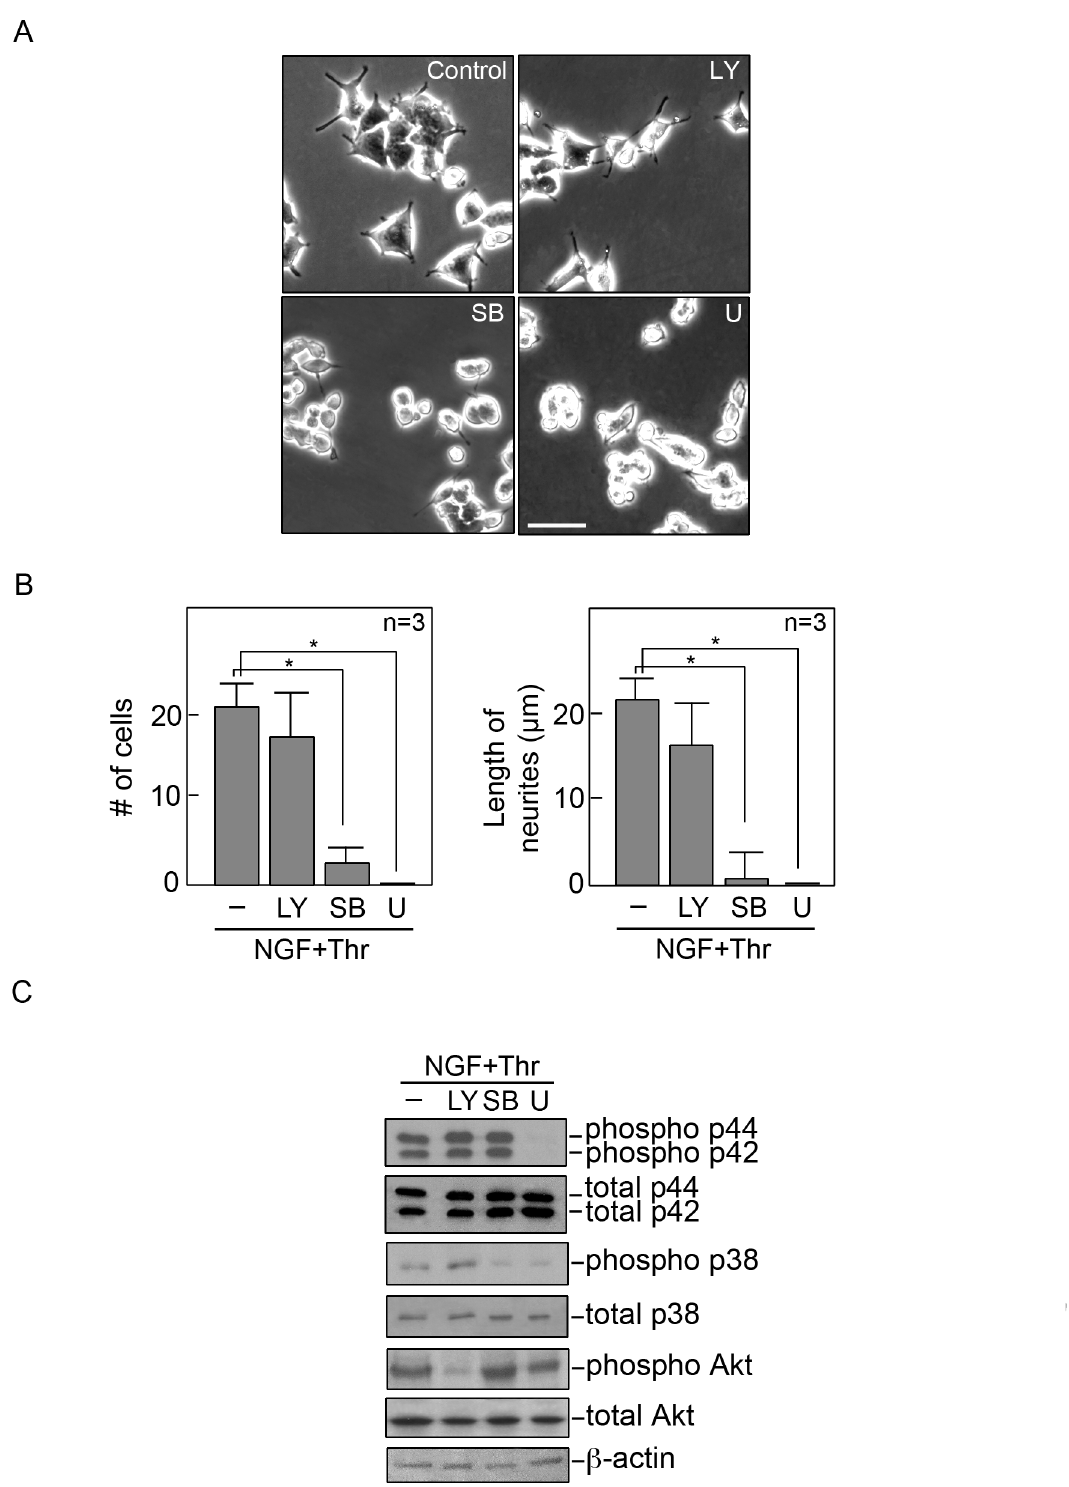
Figure 5. Inhibition of p44/42 and p38 MAPK blocks NGF + thrombin-induced neurite extension in PC12 cells. A. Cells were plated as described in Materials and Methods. After serum starvation for 18 hours, cells were treated with 10 m M of SB203580 (SB; p38 MAPK inhibitor) or U0126 (U; p44/42 MAPK inhibitor), or 30 m M of LY294002 (LY; inhibitor of the AKT upstream kinase, PI3K) for 30 min prior to treatment with NGF + thrombin under serum-starved conditions. Cells were then photographed 48 hours after culture with or without NGF- and thrombin-containing DM. Control, no inhibitor added. Scale bar=60 m m. The left panel shows the number of cells with neurites longer than 20 m m in each of the 4 treatment groups. The right panel shows the average length of neurites in each of the 4 treatment groups. Measurements were taken from 3 sets of 150 cells for each treatment group. The three sets were from 3 representative experiments. Statistical significance, using one-way ANOVA, was set at p # 0.01 and indicated by an asterisk (*). Nerve growth factor, NGF; thrombin, Thr; -, no inhibitor added. C. Cells were grown as indicated in (A) above. After pre-